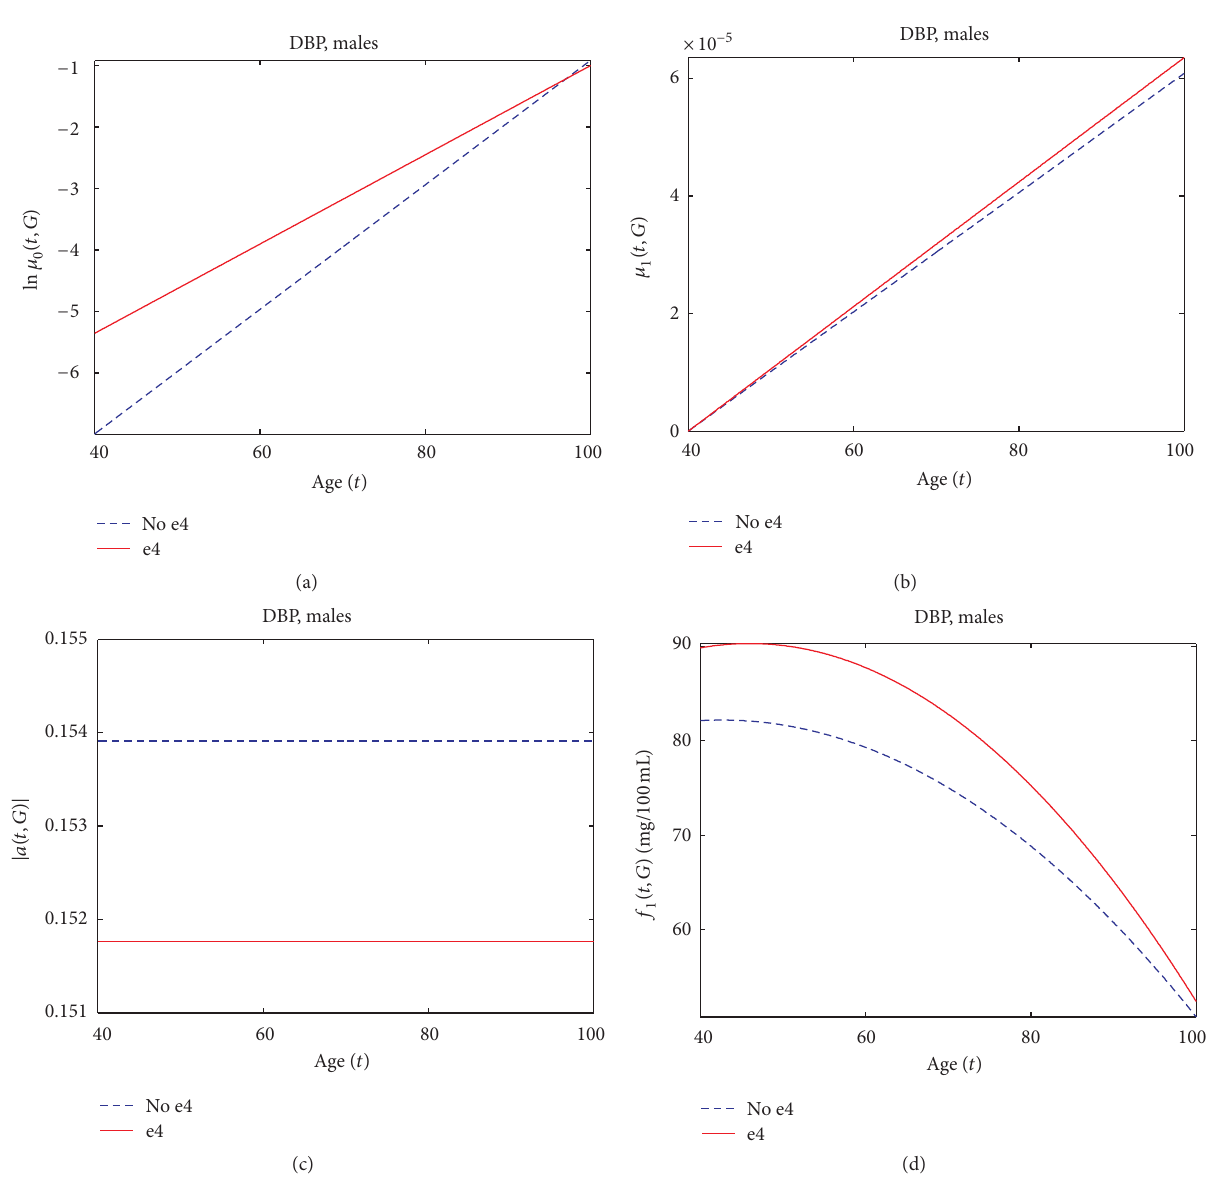
F 7: Application of the genetic stochastic process model to longitudinal measurements of diastolic blood pressure (“DBP”) and data on mortality for males in the Framingham Heart Study (original cohort): Estimates of the logarithm of the baseline hazard (a), the multiplier in the quadratic part of the hazard (b), the adaptive capacity (the absolute value of the feedback coefficient) (c), and the mean allostatic